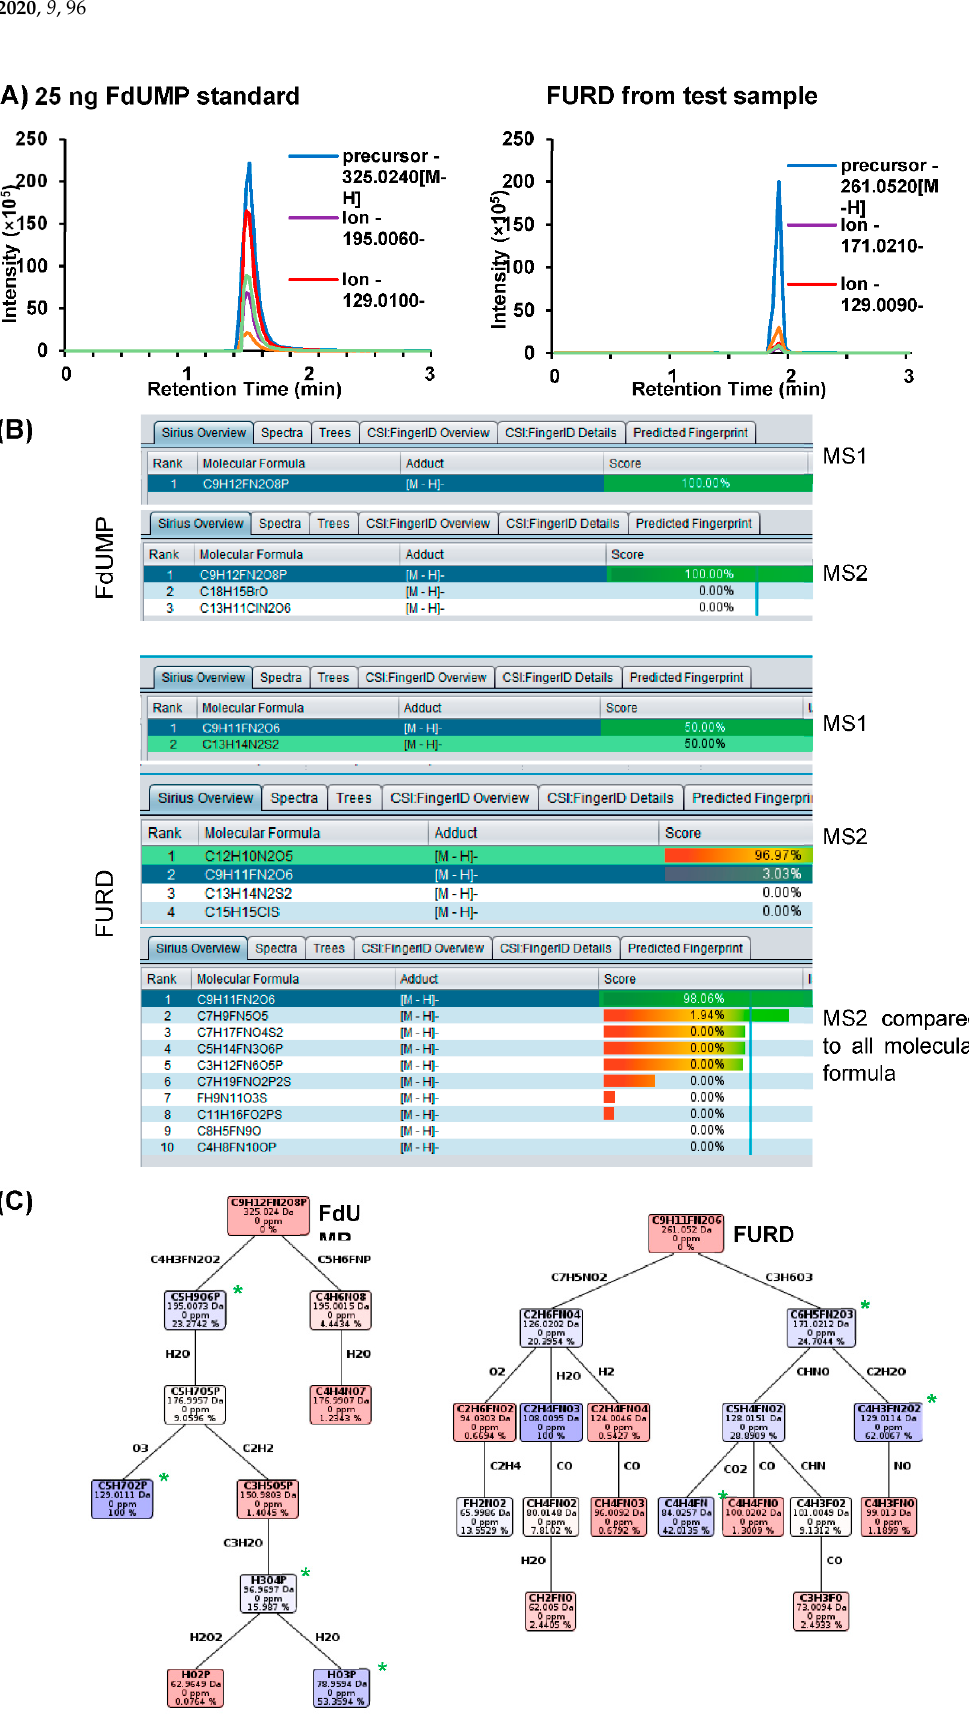
Figure 5. Isotope pattern analysis and fragmentation tree analysis using SIRIUS. To further validate the results, the experimental prediction was compared with theoretical prediction and database